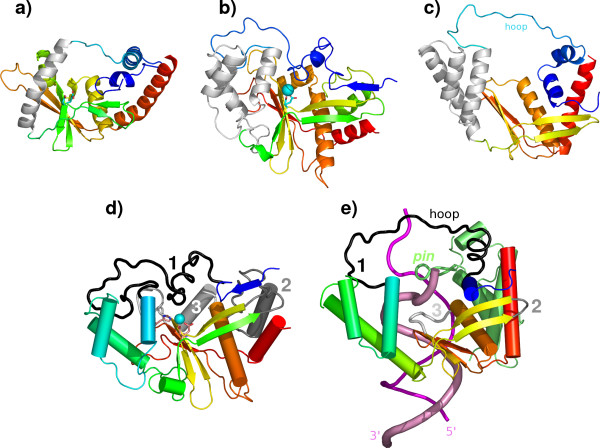
Comparisons of structurally aligned nuclease(-like) domains in λ-exonuclease, RecB and RecC. The comparison in a)-c) shows how a single helix in λ-exonuclease (PDB code 1avq; [5]) (a) has been replaced by superimposable α-helical bundles in RecB (b) and RecC (c) (PDB code 1w36; [18]), indicating a more recent shared ancestor of the latter pair. The regions in question are shown as light grey. The remainders of the molecules are coloured in a spectrum from blue (N-terminus) to red (C-terminus). In a) and b), two acidic, metal-ligating residues drawn as sticks mark respective catalytic sites. RecB and RecC are compared in more detail in d) and e), respectively, again coloured from blue to red with the exception of labelled key regions 1 (black), 2 (dark grey) and 3 (grey). Bound metal is shown in b) and d) as spheres while e) additionally shows DNA (shades of pink) and the domain 4 of RecC, coloured uniformly lime green with its pin structure labelled. The DNA strand that penetrates the hoop provided by RecC is shown as a broader cartoon. The RecC "hoop" region (see text for details) is labelled in c) and e) and DNA strand termini are labelled in e).